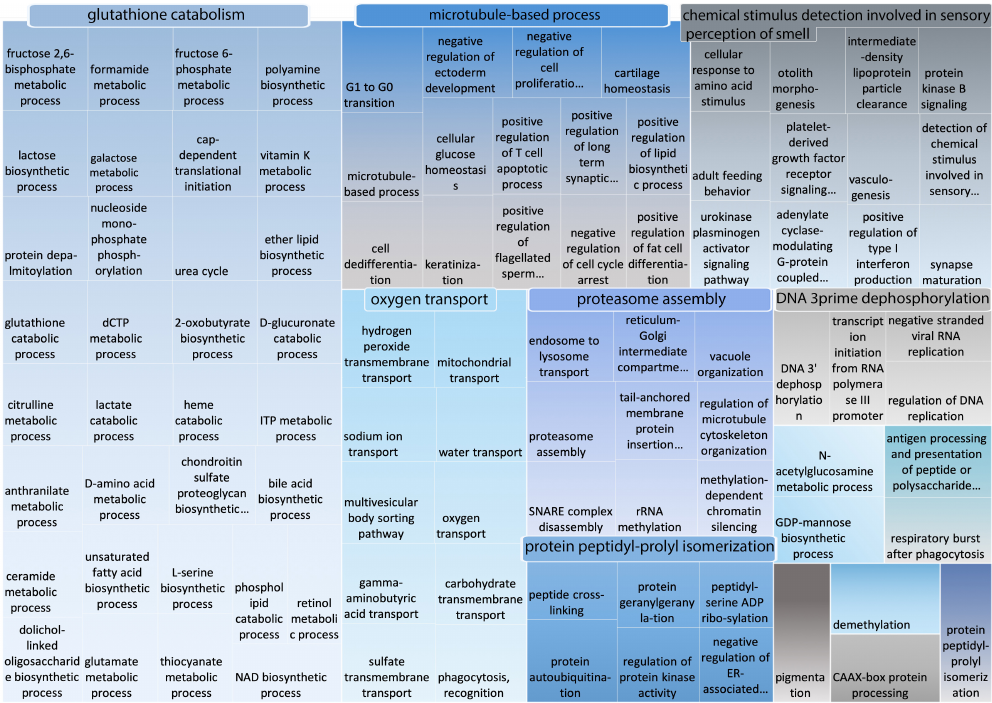
Figure 6. REVIGO representation of GO biological process terms (with PPV > 0.7) that are more enriched in Camelus disordered proteins than in those of Homo sapiens . Disordered proteins are those containing at least one “long disordered region” based on DISOPRED predictions.